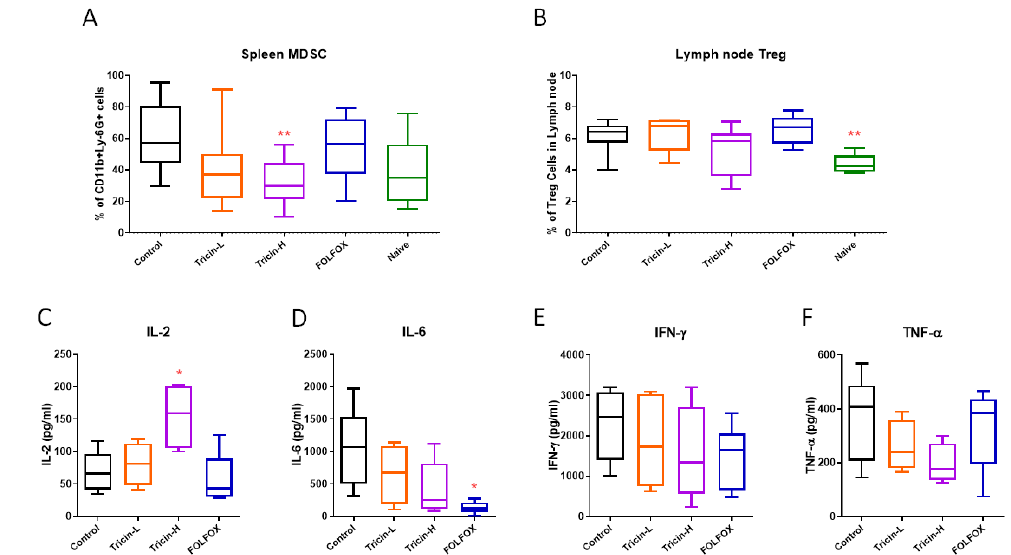
Figure 5. Effects of tricin and FOLFOX on immune cell populations and cytokine productions in orthotopic colon tumor-bearing mice. Spleens and lymph nodes were collected from different groups including naïve group (without tumor cell inoculation). Populations of ( A ) MDSC in spleens and ( B ) Treg in lymph nodes were determined by flow cytometry. Spleen lymphocytes were isolated and then activated with PHA (10 μg/mL). ( C – F ) Cell supernatant was collected after 24 h incubation and subjected to ELISA for determination of cytokines (IL-2, IL-6, IFN-γ, TNF-α) productions. Results were expressed as box and whisker plots, n = 7–13. Differences among treatment groups were determined by one-way ANOVA followed by Tukey’s multiple comparisons test, * p < 0.05, ** p < 0.01 as compared with control group.